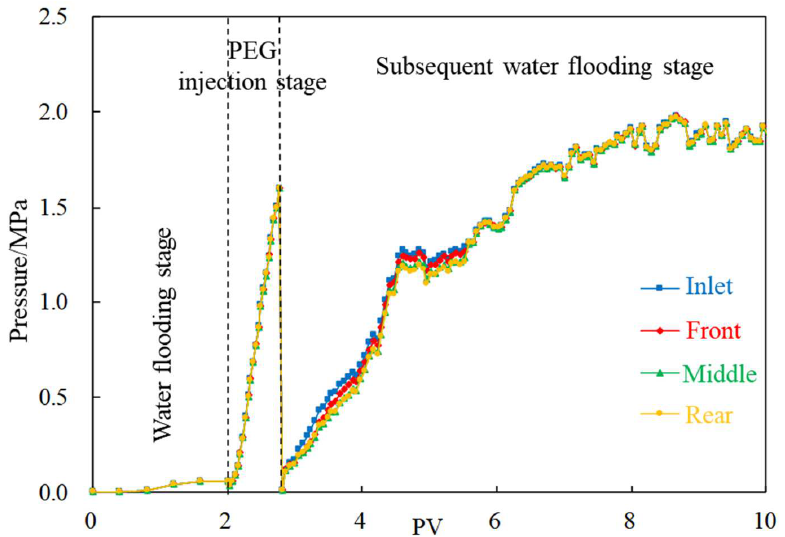
Figure 6. Typical displacement pressure change curve (injection rate is 0.2 mL/min). According to experiments B-1~B-3, the pressure curves under different injection rates are drawn, as shown in Figures 7 and 8. In the cores with fracture channels, the pressures of the front, middle and rear sections are basically the same. When the injection rate is 0.1 mL/min, the overall pressure is low, and the plugging effect is ordinary. On the other hand, when the injection rate is 0.2 mL/min, the pressure rises steadily and is generally stable. Therefore, 0.2 mL/min is considered as the optimal injection rate.